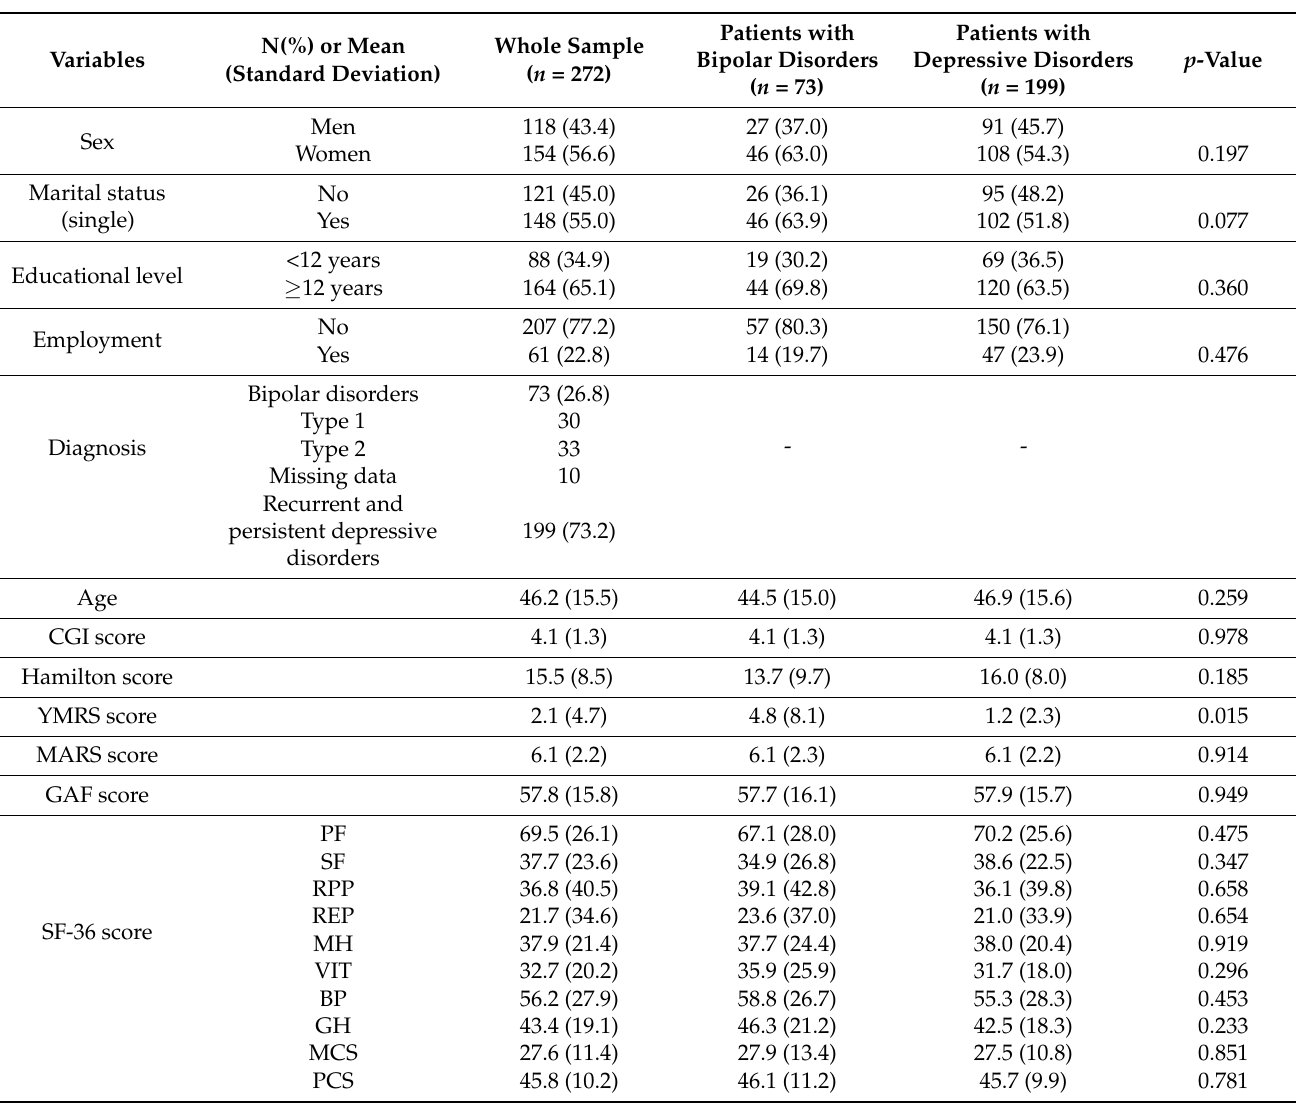
Table 1. Characteristics of patients ( n =